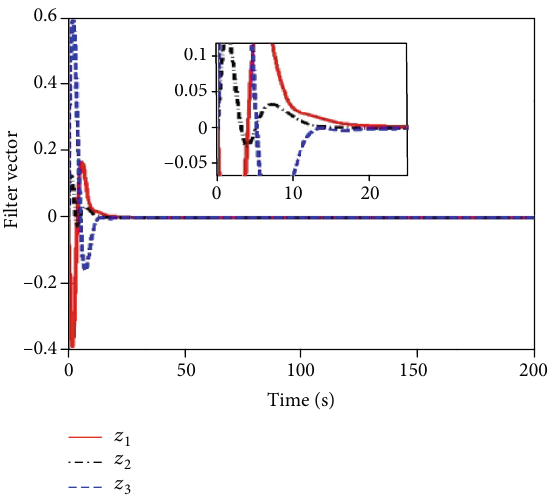
Figure 21: Time histories of fi lter vector in Case 3 when k ð 0 Þ = 5